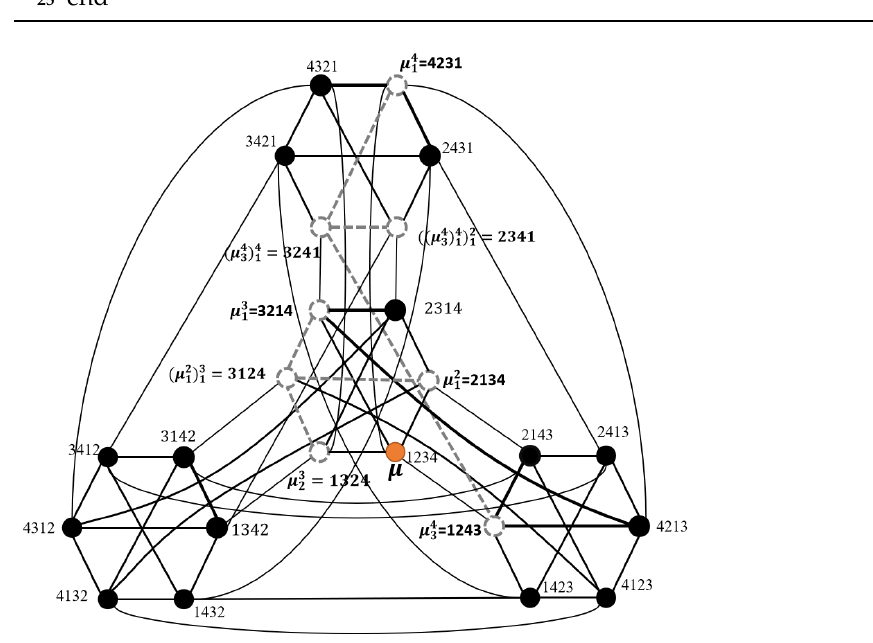
+ 2 and κ s ( BS n ; K 4